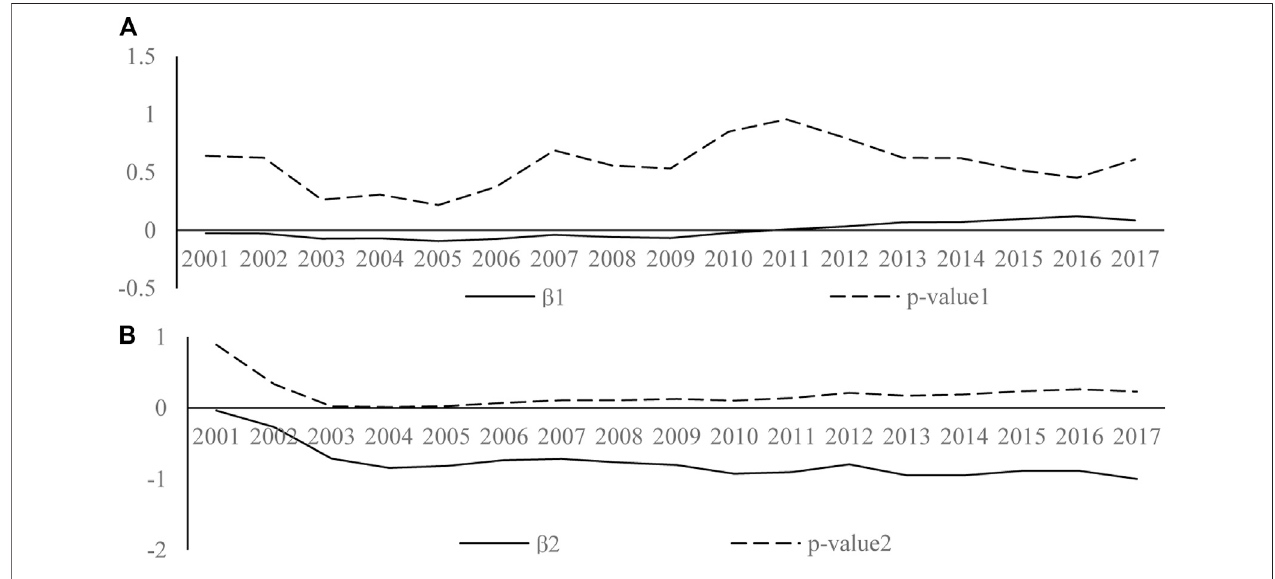
FIGURE 2 | Annual effects of LEE on CO 2 emissions and economic